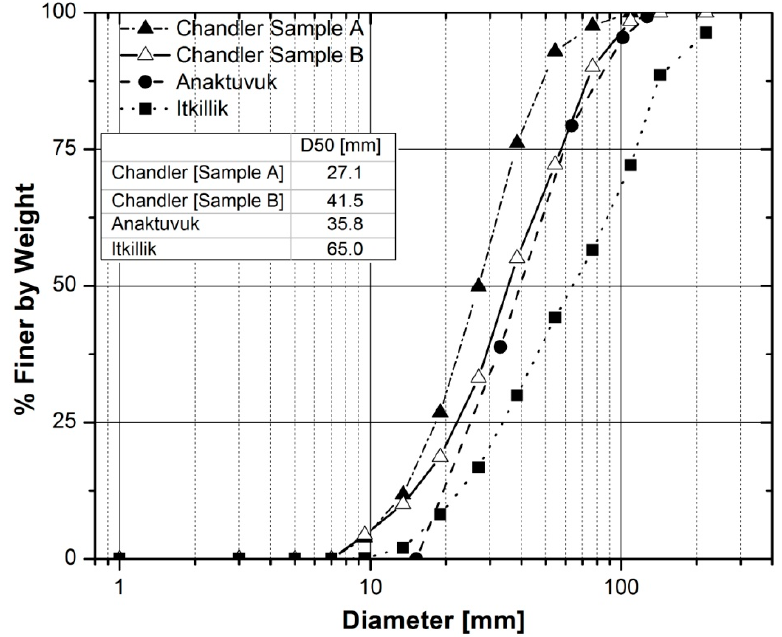
Figure 2. Grain ‐ size distributions of surficial sediments. Figure 2. Grain-size distributions of surficial